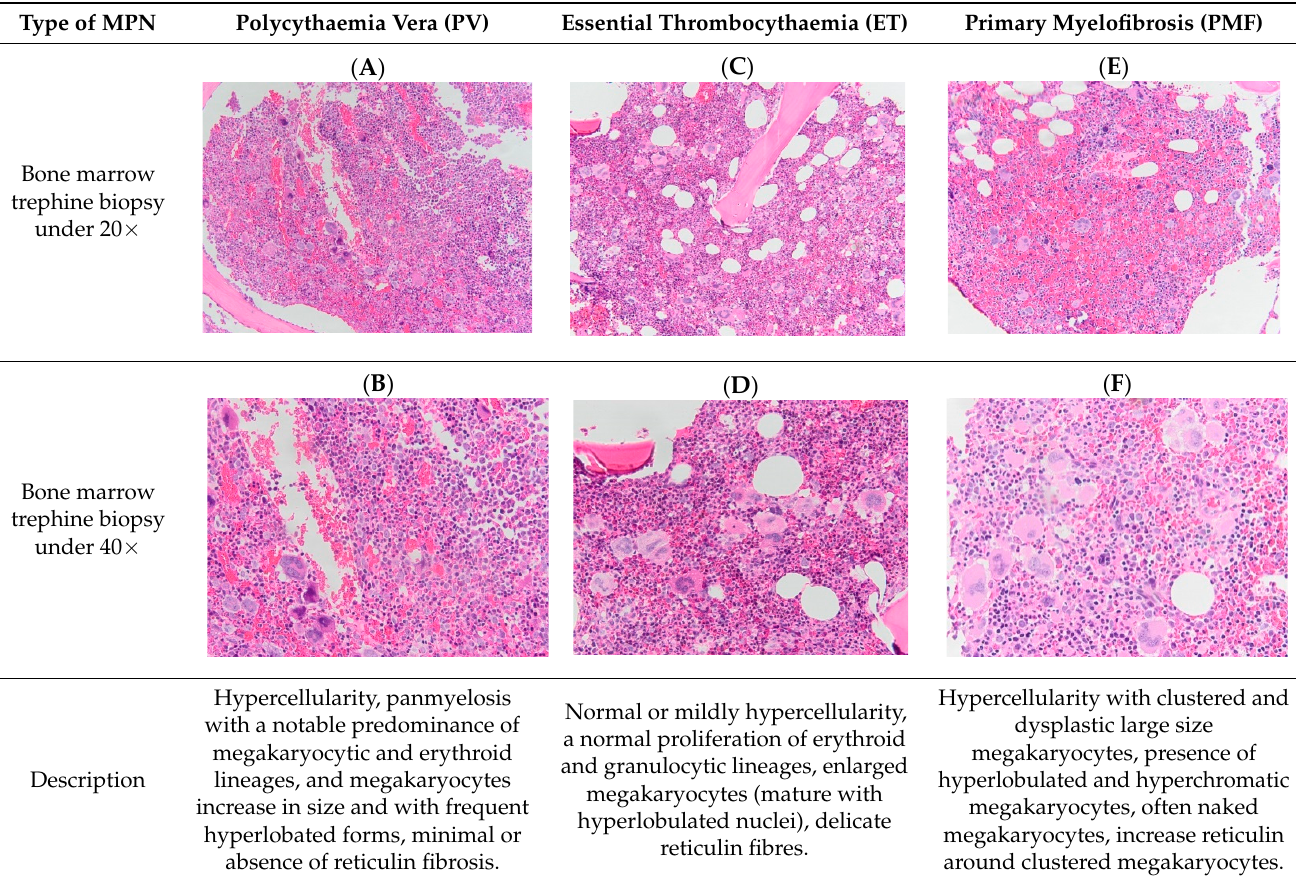
Table 1. Bone marrow trephine biopsy of classical BCR-ABL-negative MPN under 20× and 40×. ( A , B ) Polycythaemia vera. ( C , D ) Essential thrombocythaemia. ( E , F ) Primary myelofibrosis.